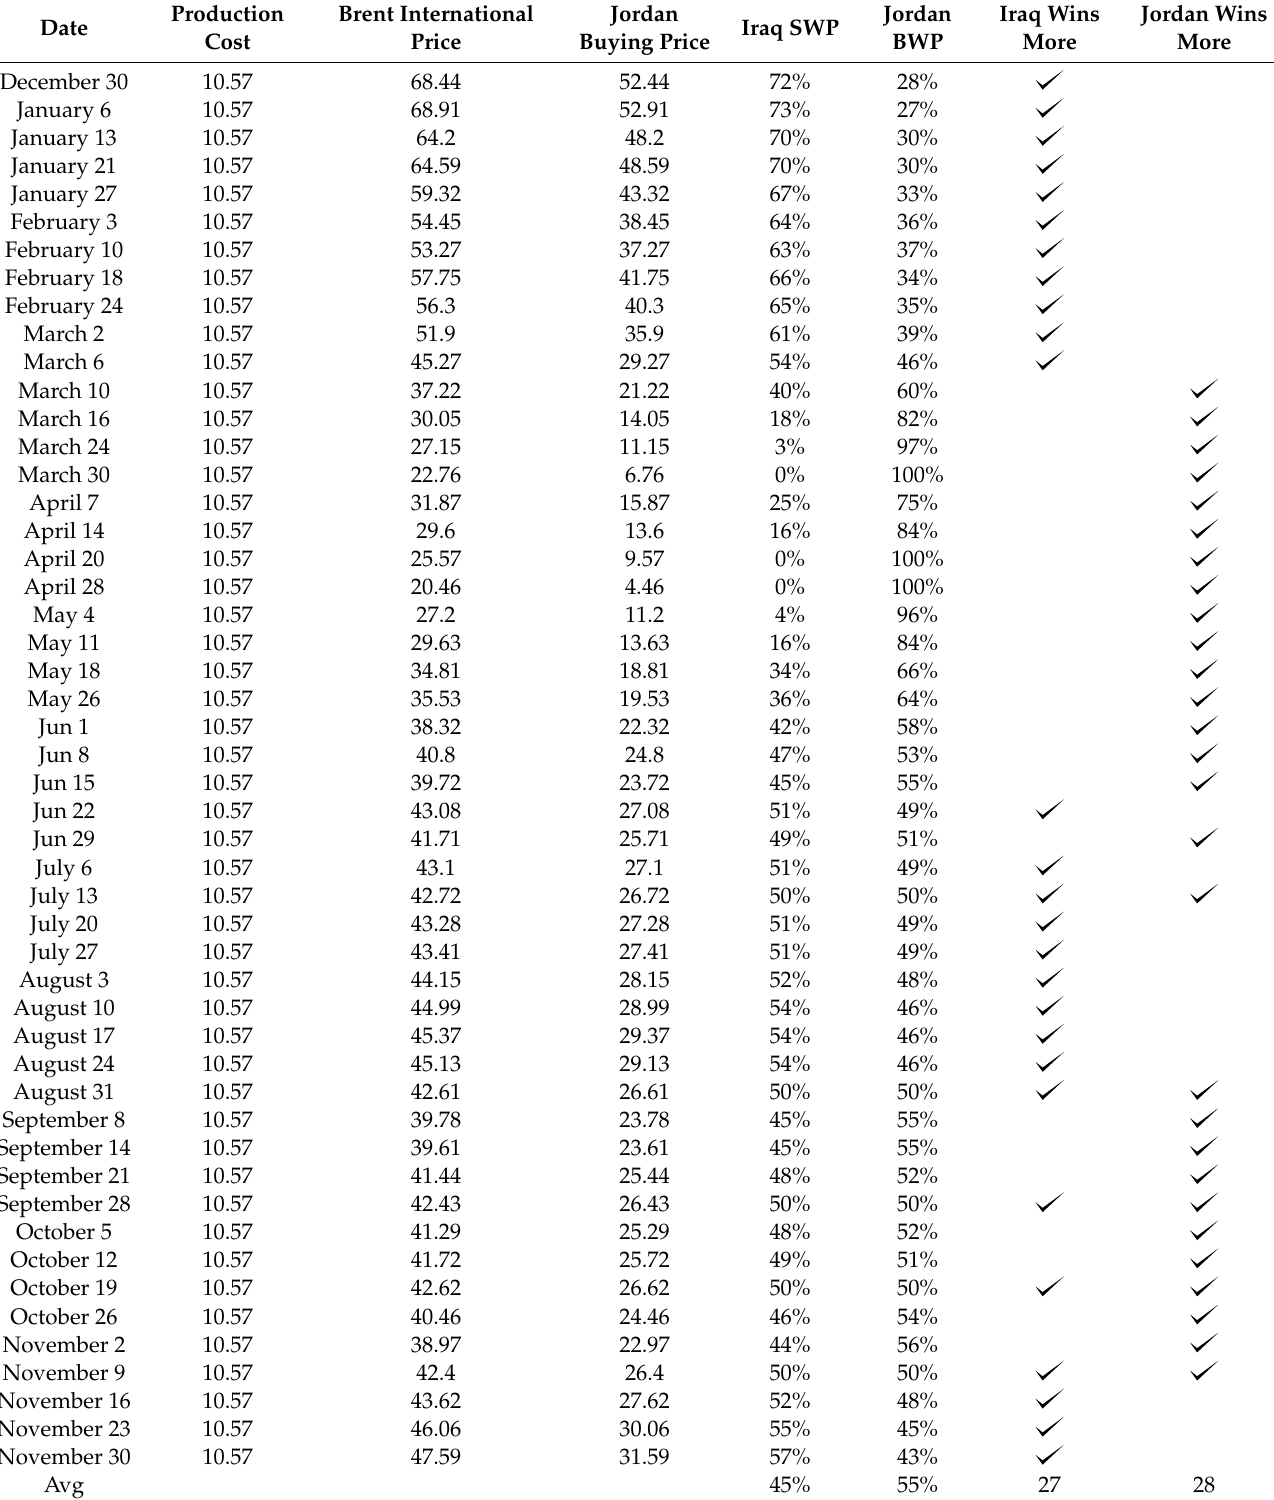
Table 3. Information about the oil deal between Iraq and Jordan, with the winning percentages calculated using the proposed